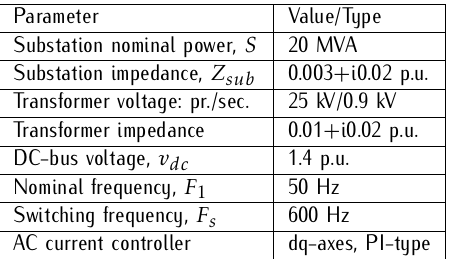
Table 3. Parameters values used in the simulations.